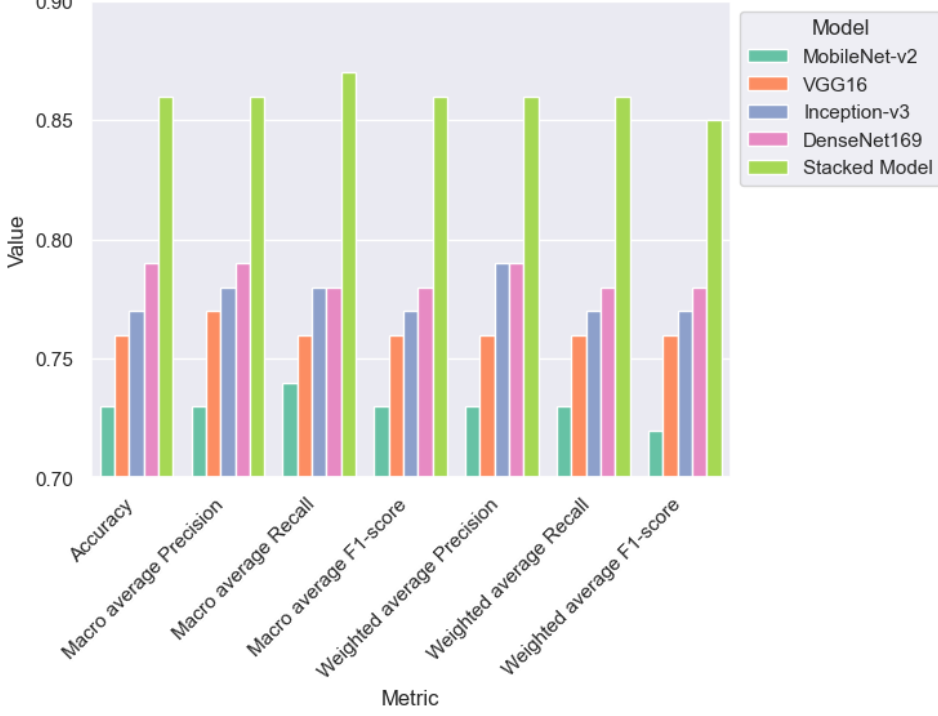
Figure 17. Global evaluation metrics for each